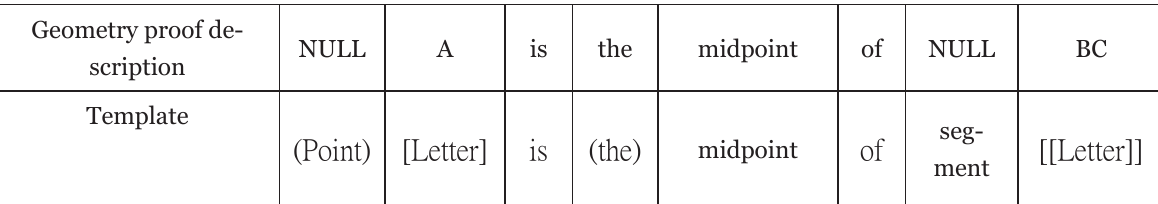
Result of Template Matching for Sentence